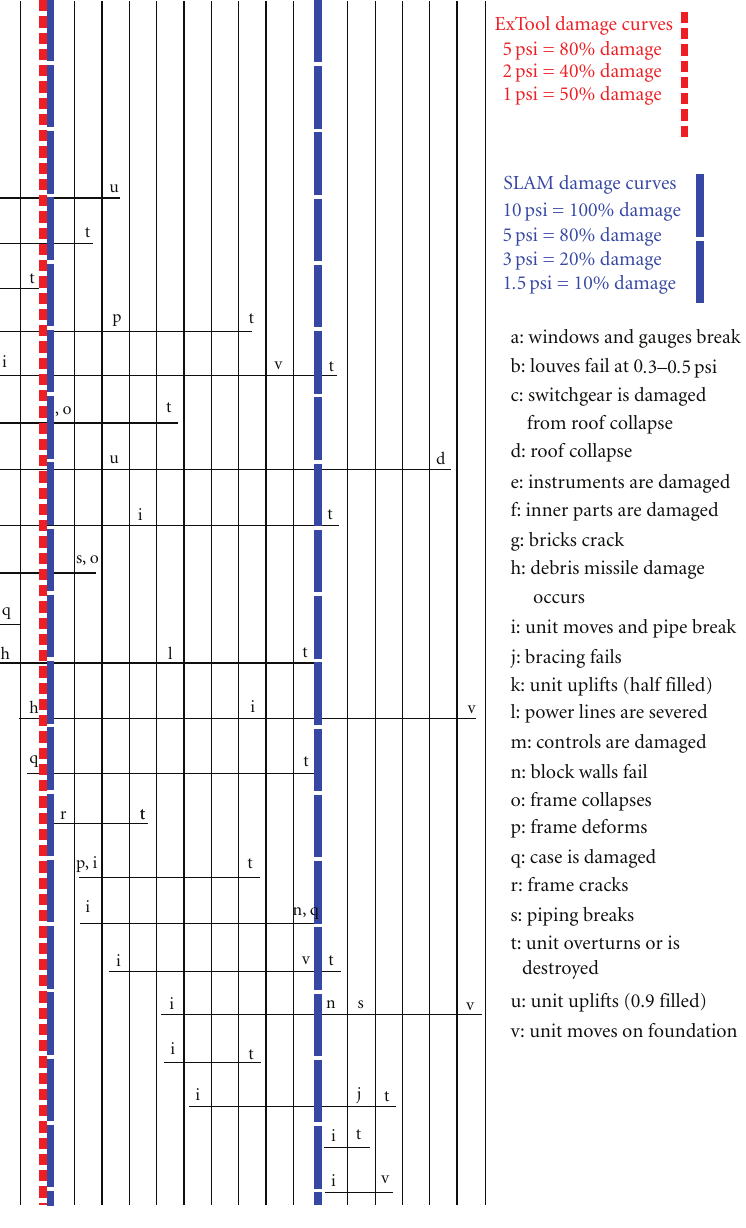
Figure 6: Threshold values from US Department of interior, O ffi ce of Oil and Gas